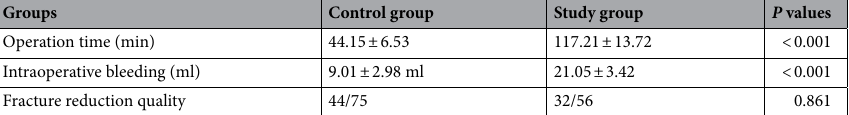
Table 2. Comparison of two groups of clinical indicators( x ± s). The nonparametric Wilcoxon rank sum test was performed on the operation time and intraoperative bleeding volume, and the result showing statistical difference. The chi-square test was conducted for the Fracture reduction quality and the result without statistical significance.